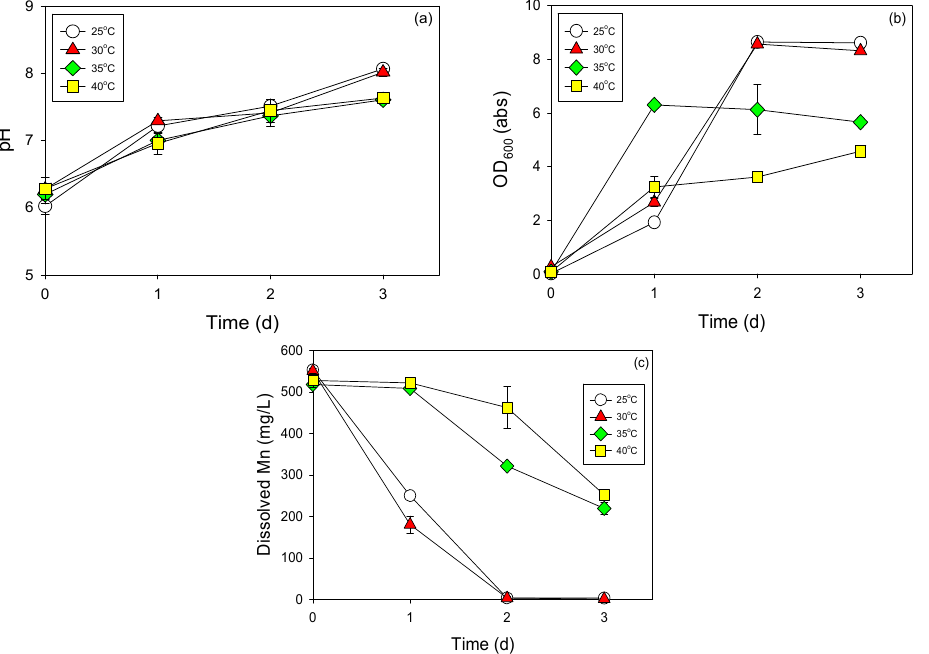
Figure 2. Manganese removal by strain NDMn-6 at various incubation temperatures. Changes in ( a ) pH ( a ), optical density ( b ), and dissolved Mn ( c ).